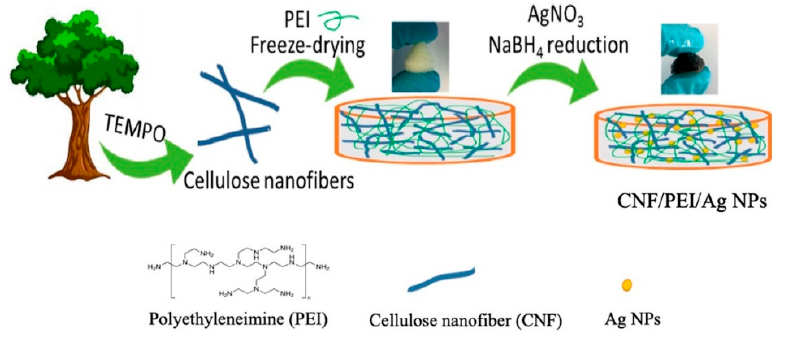
Figure 9. A scheme of the composite fabrication [218].